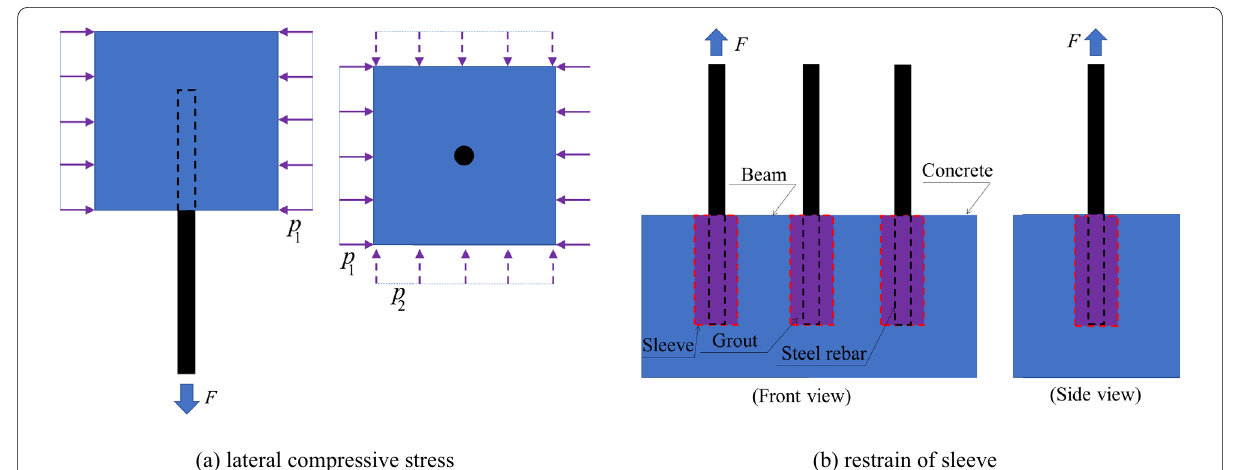
Fig. 3 Effects of lateral